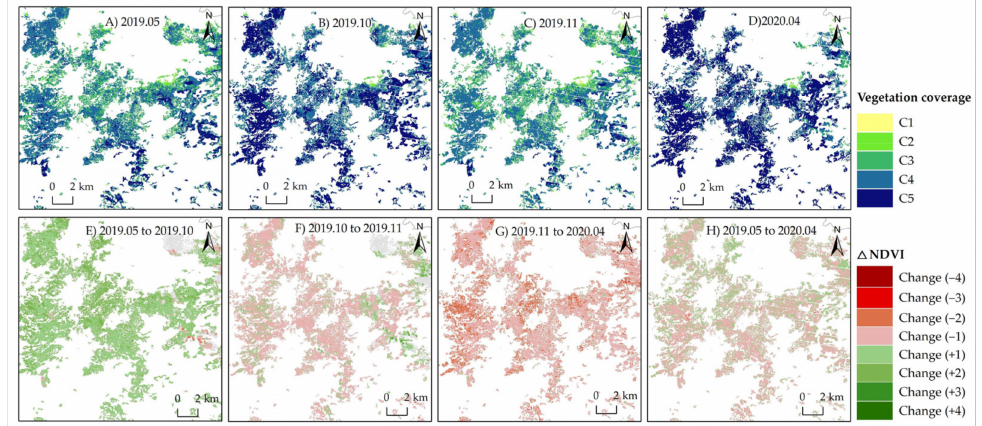
Figure 3. Variation of Yunnan pine forest coverage and NDVI in May, October, and November 2019 and April 2020. ( A – D ) are maps of pine forest coverage; ( E – H ) are ∆ NDVI. Table 4. Yunnan Pine forest coverage and ∆ NDVI ratios in May, October, and November 2019 and in